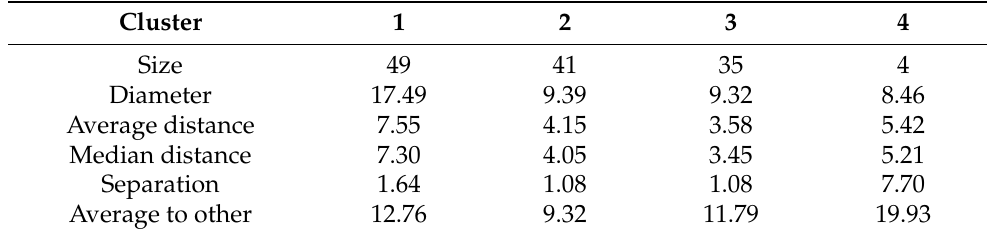
Table 6. Statistical properties of the four clusters